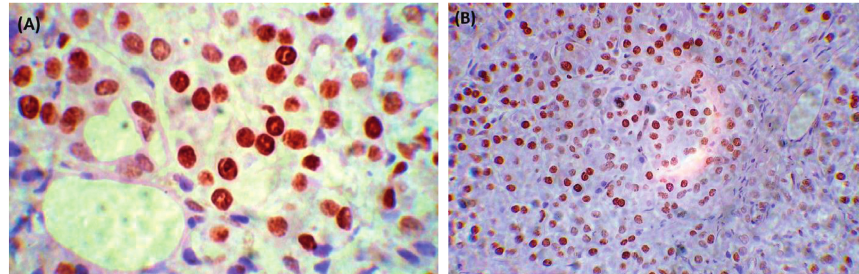
Figure 2: (a) Immunohistochemistry of pancreatic adenocarcinoma scored at 40x. Hematoxylin counterstain; (b) immunohistochemistry of normal pancreas scored at 20x. Hematoxylin counterstain.